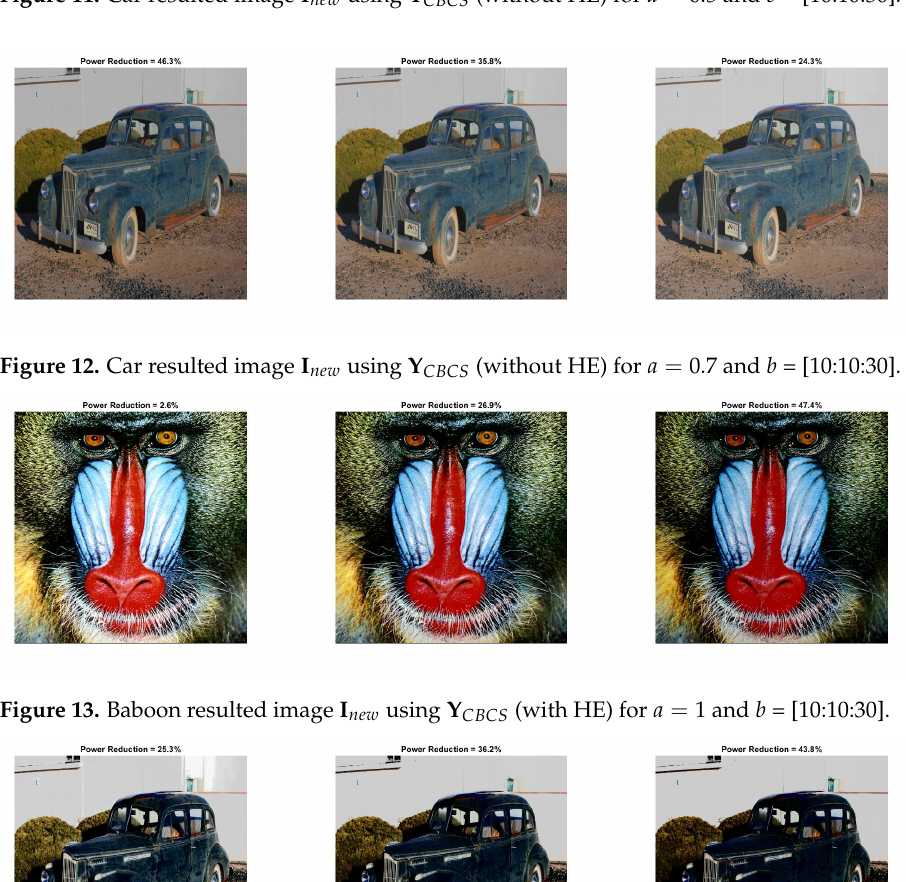
Figure 11. Car resulted image I new using Y CBCS (without HE) for a = 0.5 and b = [10:10:30].